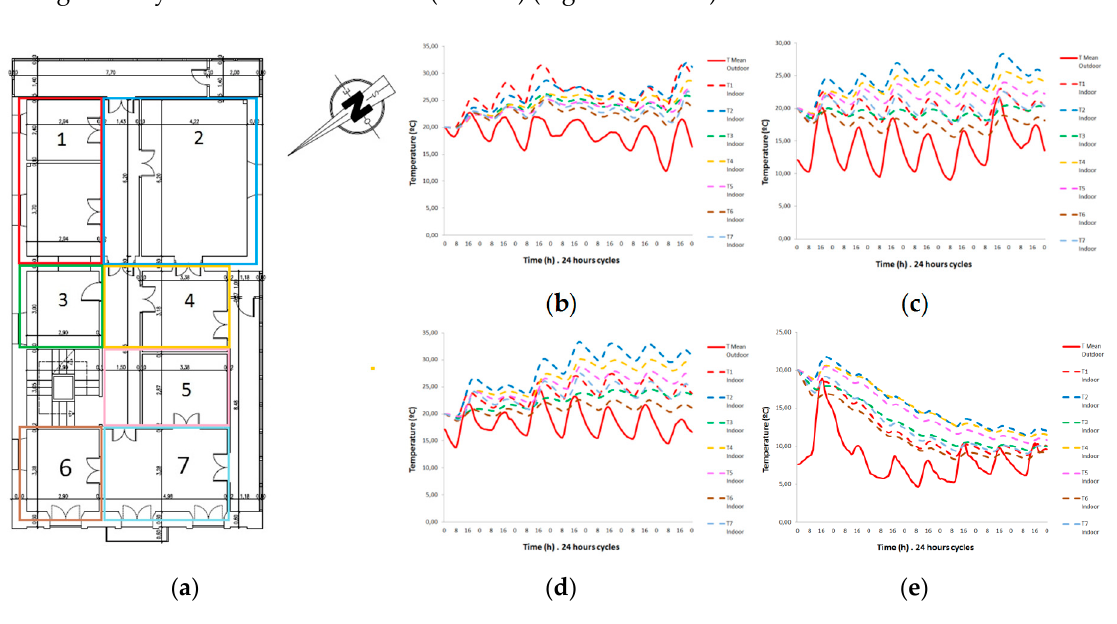
Figure 2. ( a ) Thermal zones on the existing first floor of the TAH, numbered from 1 to 7. T Mean Outdoor and 1–7 Thermal zones T Indoor from 22 to 28: ( a ) March ( b ) June ( c ) September ( d )